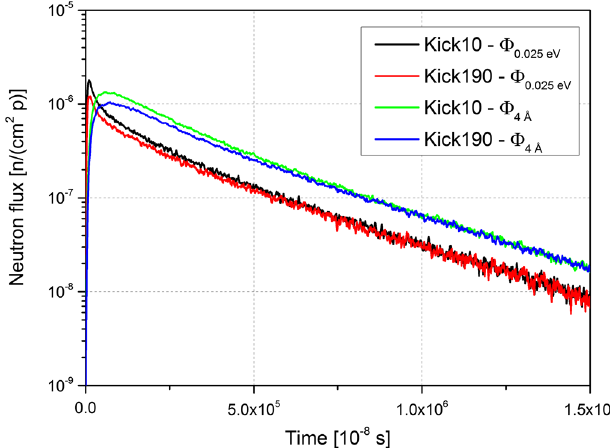
FIG. 15. The time-dependent cold (at 4 Å) and thermal (at 0.025 eV) neutron flux in the D 2 source for the beam profile cases depicted in Fig. 14.